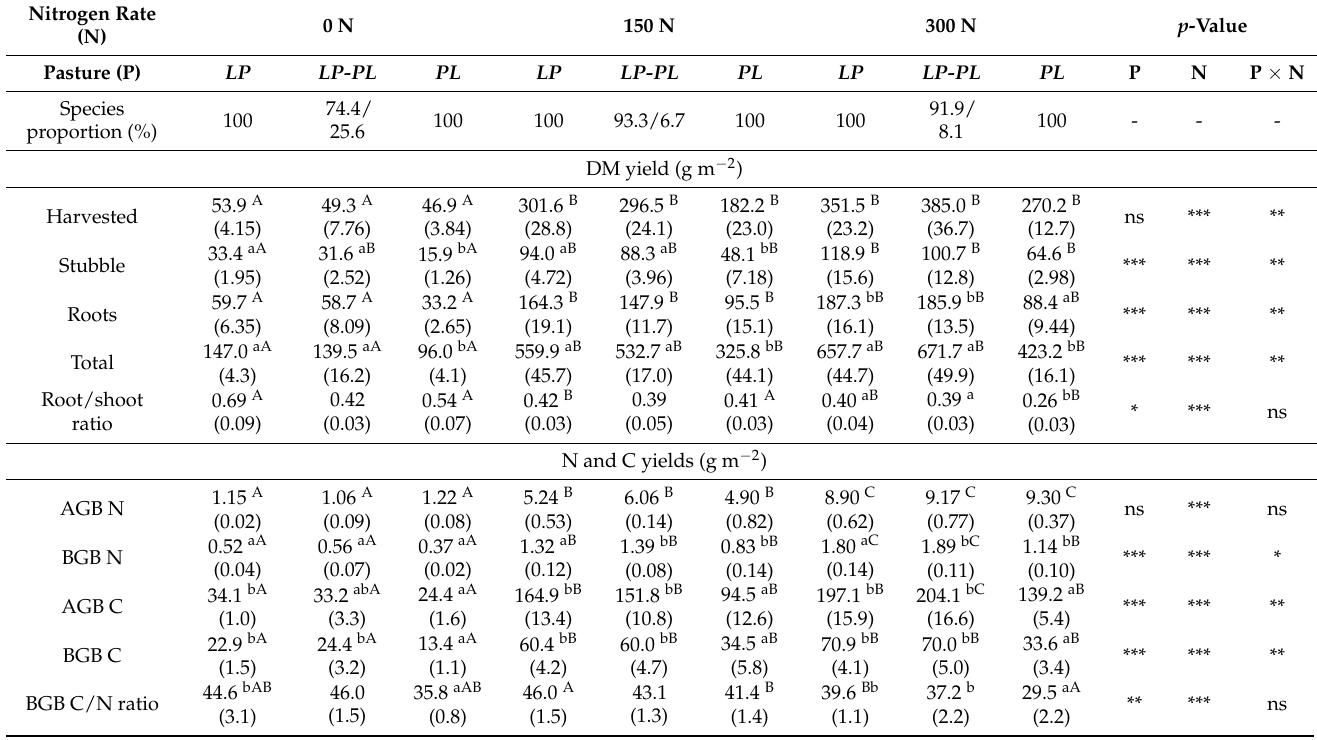
LP represents Lolium perenne; PL represents Plantago lanceolata. SEM = standard error of the mean (pooled across pastures) and fertilization rates; means with different letters are different at p < 0.05, ab represent the effect of the sward type and ABC represent the effect of the fertilization rate; ns p > 0.05, * p < 0.05, ** p < 0.01 and *** p < 0.001. AG is the aboveground biomass (harvested + stubbles); BG is thebelowground biomass. The plant biomass α is AG +